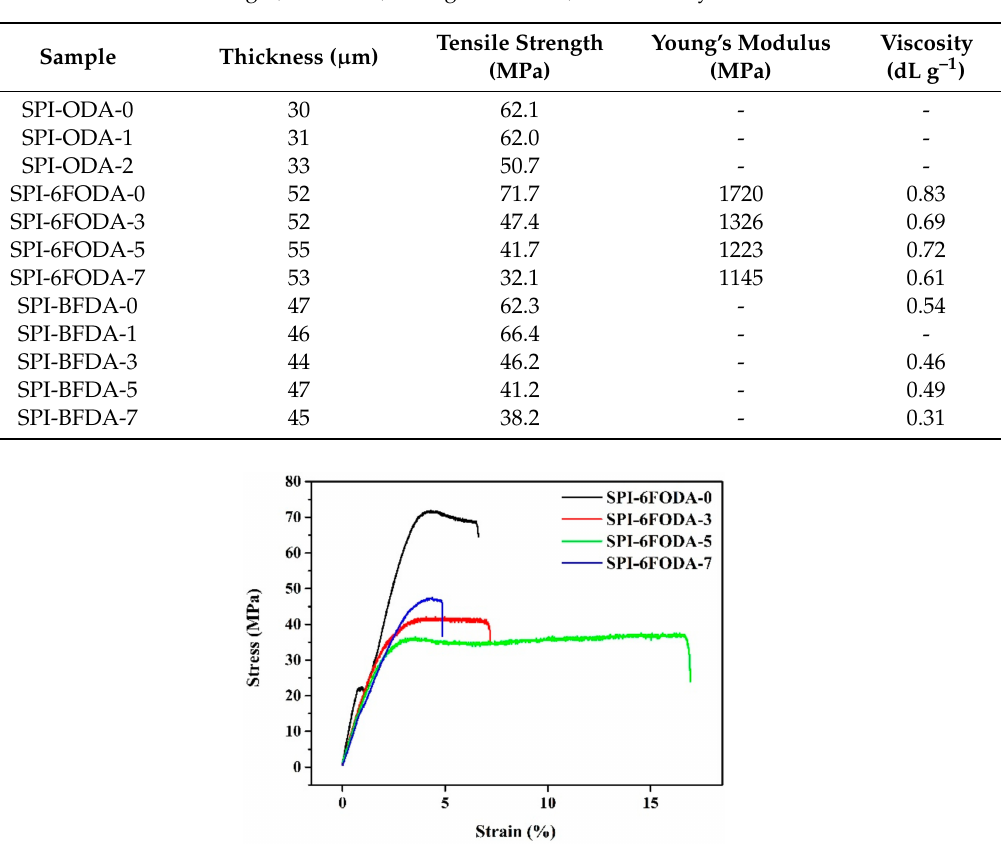
Figure 6. Stress–strain curves of the membranes based on